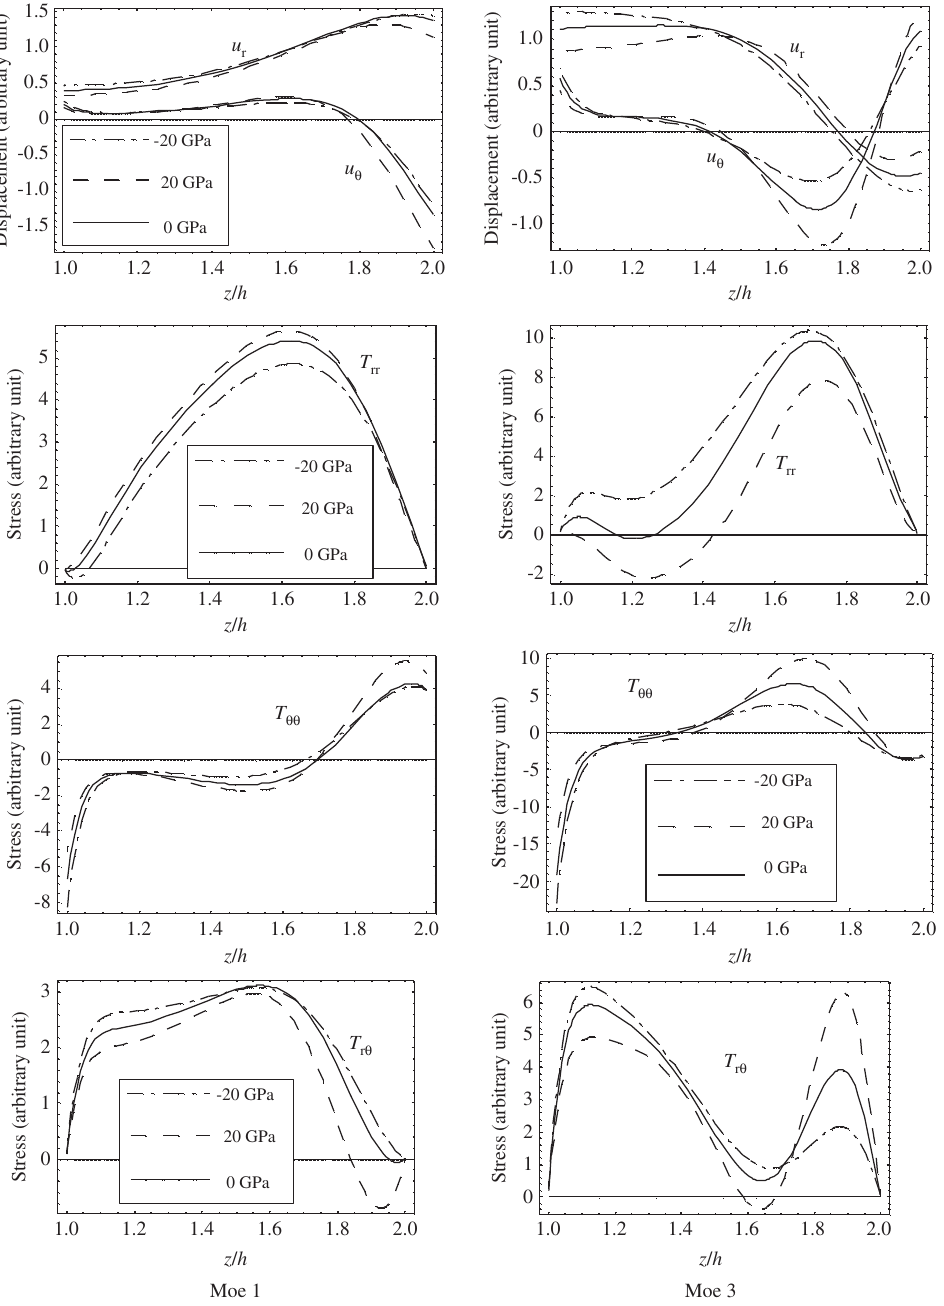
Figure 6 Displacement and stress distributions of circumferential Lamb-like wave for the linearly graded cylindrical plate with η = 2 under different radial initial stress at kh =